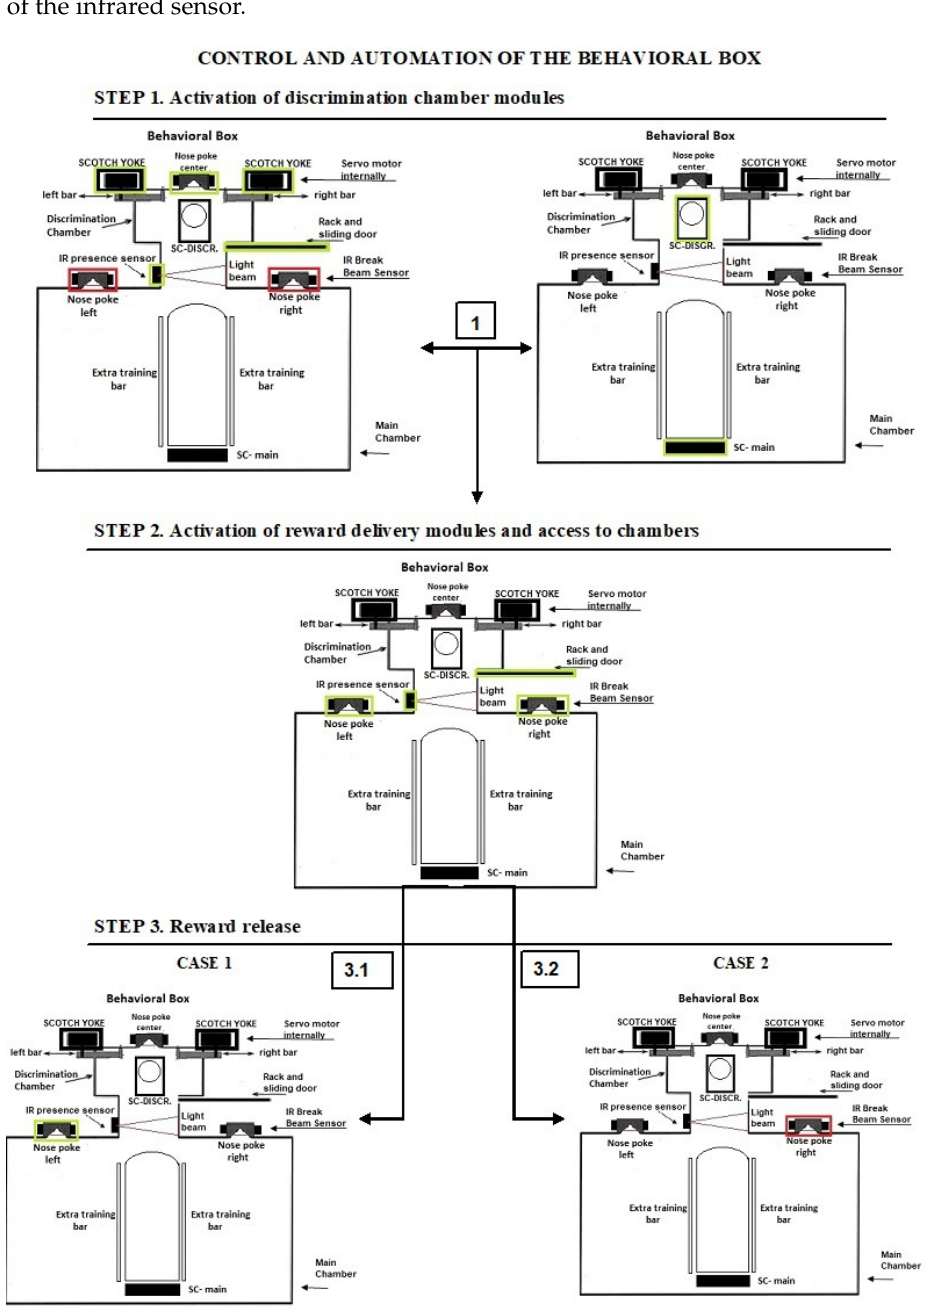
Figure 4. Basic functioning diagram, with three phases and two sub-cases in the last phase (3.1 and 3.2), which are just examples of some processing. In 3.1 the nose poke left is turned on and in 3.2 the nose poke right is turned